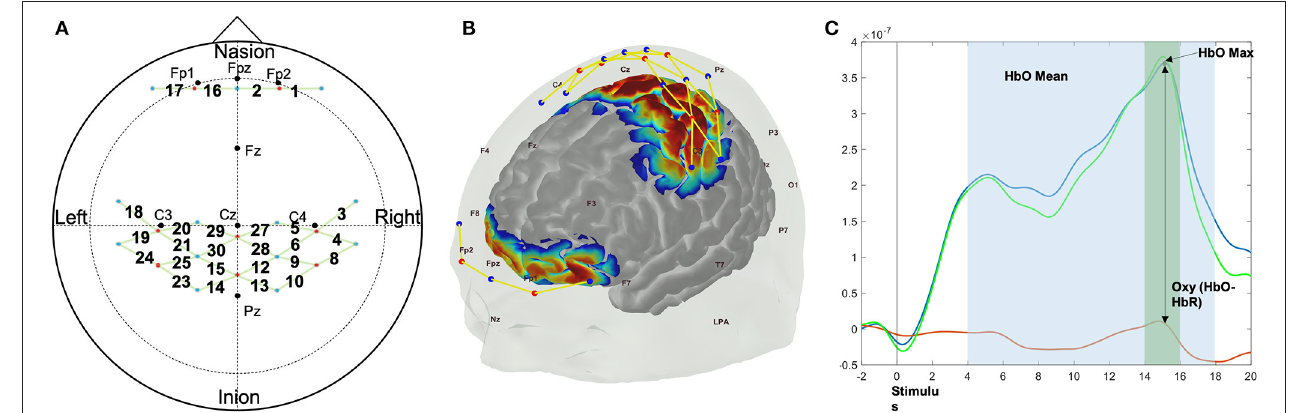
FIGURE 2 | fNIRS custom probe design (A) , the sensitivity map on the brain surface that shows the areas of interest (frontal, motor, and sensory area) measured using the custom probe design (B) , and the sample hemodynamic responses during force control trials that shows how neural activations are quantified in the present study (C) . The red dots show the location of light emitters and the blue dots show the location of detectors. The yellow lines between red and blue dots show the location of each channel (numbers) where the hemodynamic responses were measured (A,B) .